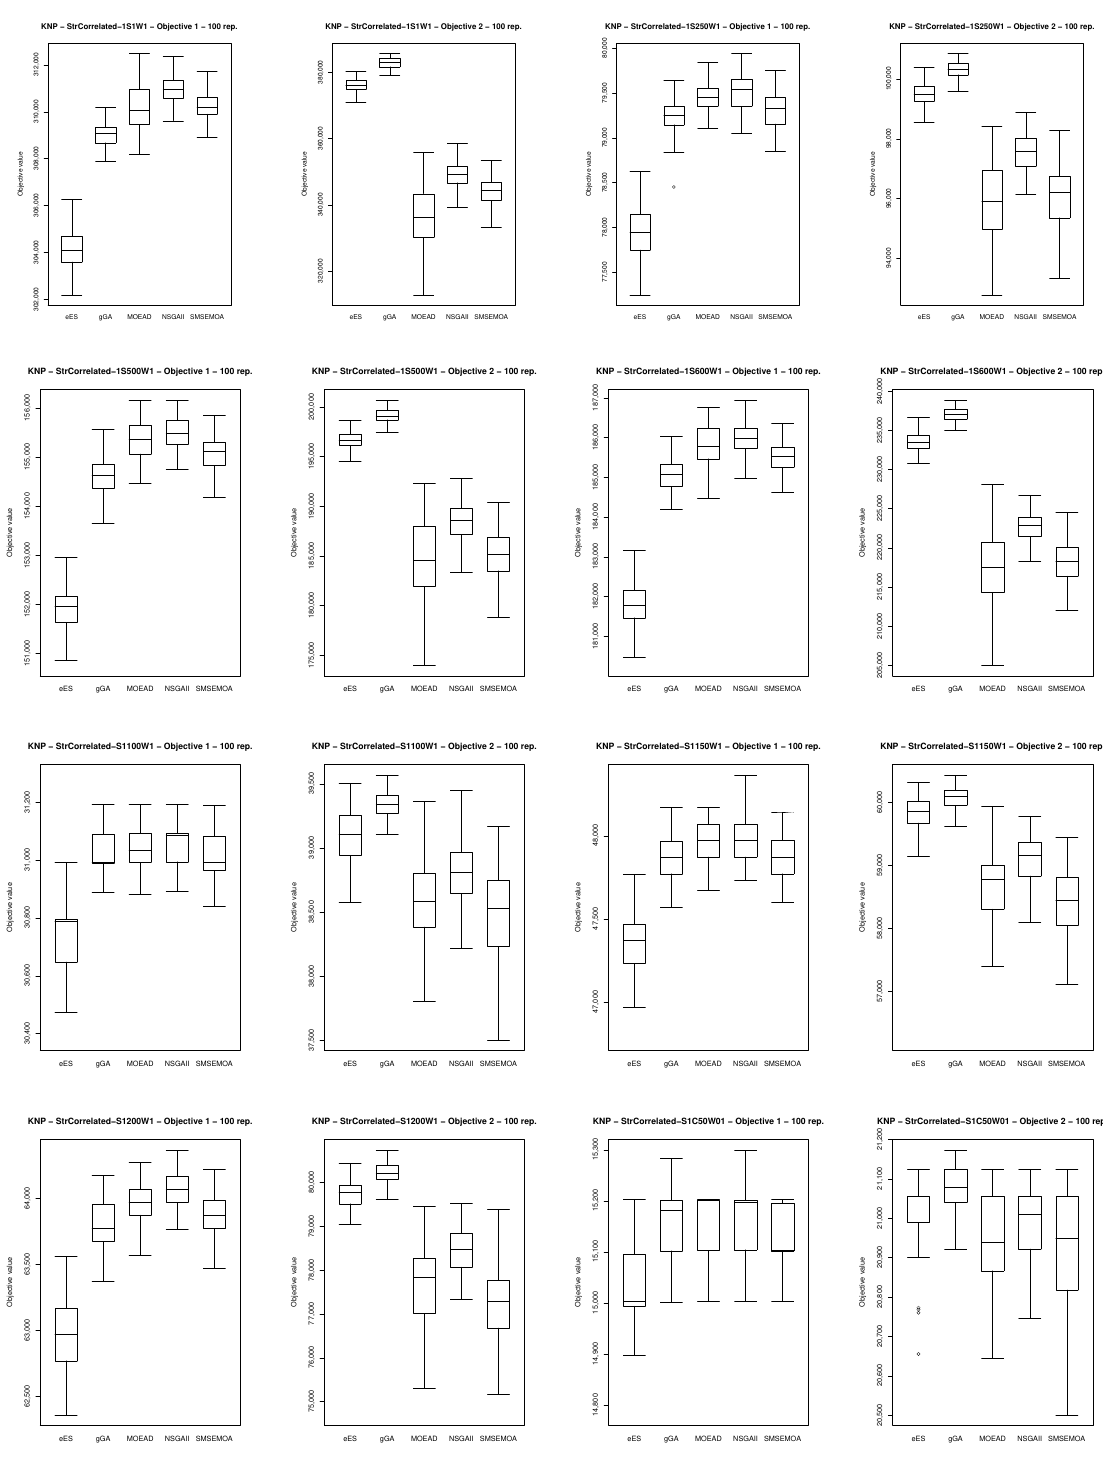
Figure 5. Boxplots showing the results for the KNP (strongly correlated instances) achieved by the different single-objective and multi-objective approaches at the end of 100 repetitions of the runs. Some instances were omitted because of space restrictions. However, all graphics can be found in the repository associated with this